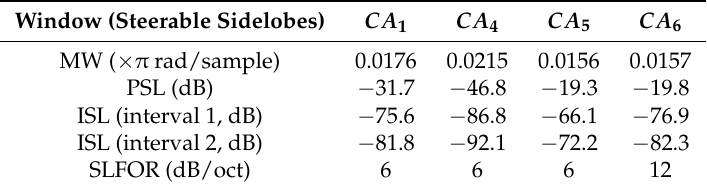
Figure 3. Window functions with steerable sidelobes. Table 2. Property Comparison (steerable